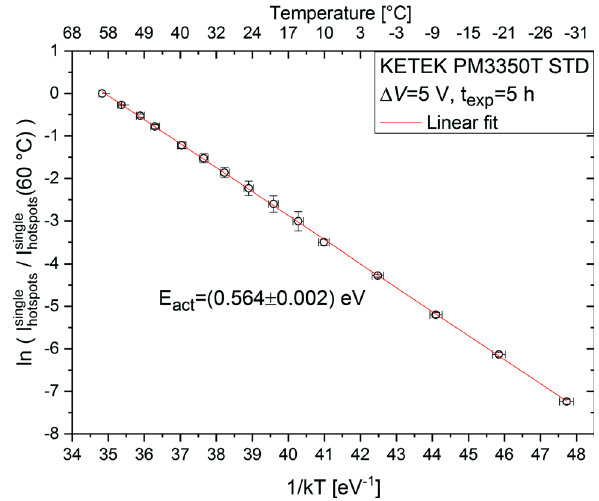
Fig. 13 Arrhenius plot of I single 60 ◦ C ) , for 5 random